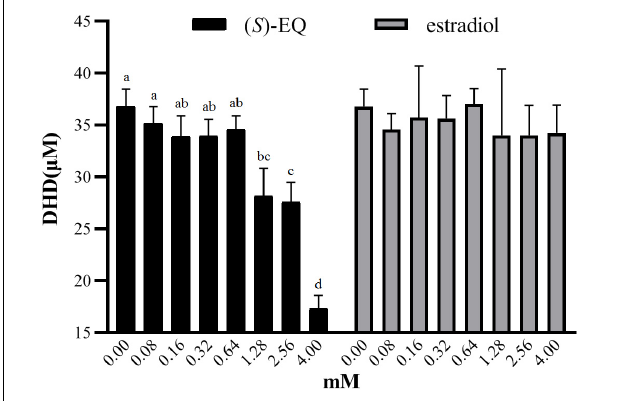
FIGURE 6 | Effects of ( S ) - EQ and estradiol on the reductase and oxidase activity of K-07020. (A) Effects of ( S )-EQ on DHD production when using DZN as reaction substrate. (B) Effects of estradiol on DHD production when using DZN as reaction substrate. Different lowercase letters indicate significant difference between groups ( P < 0.05). With a concentration of ( S ) - EQ exceeding 1.28 mM, the reaction proceeded toward DZN formation and showed a concentration dependent increase in oxidase activity with increasing ( S ) - EQ